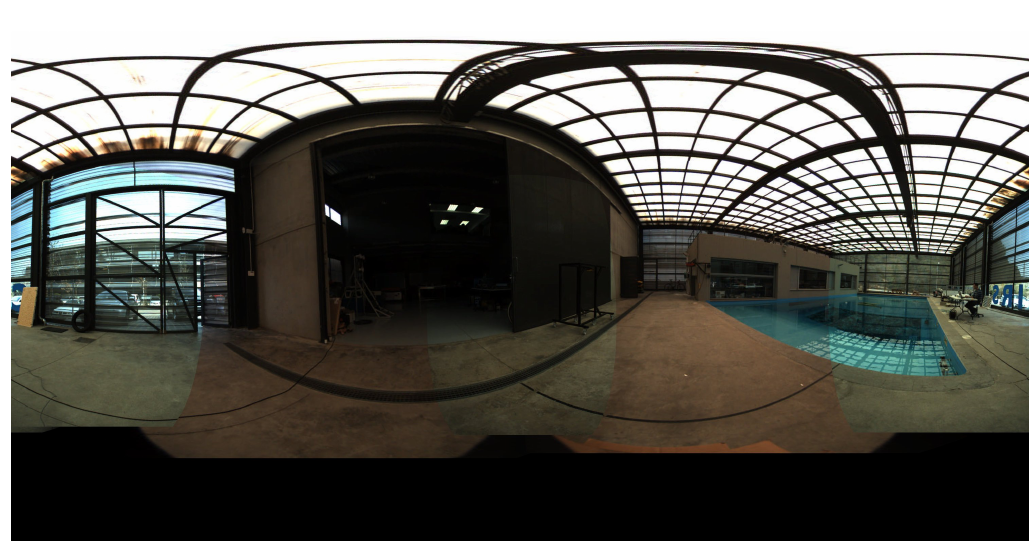
Figure 19. Equirectangular projection of the interior of the CIRS building, created with a re-projection distance of 10 m and using the closest blending